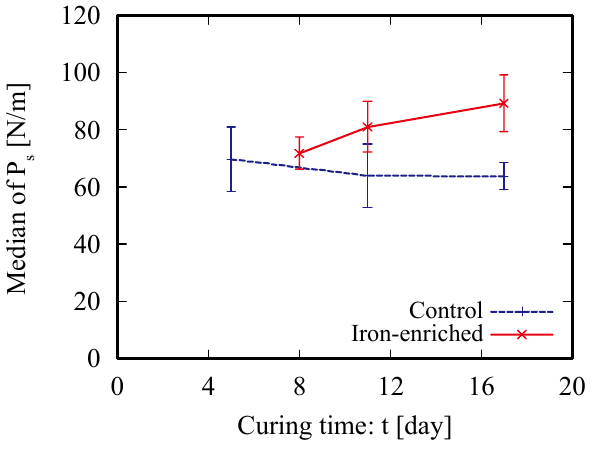
Fig. 17 Effect of environment on the change in adhesive strength due to lapse of time (error bars show normalized inter quartile range of